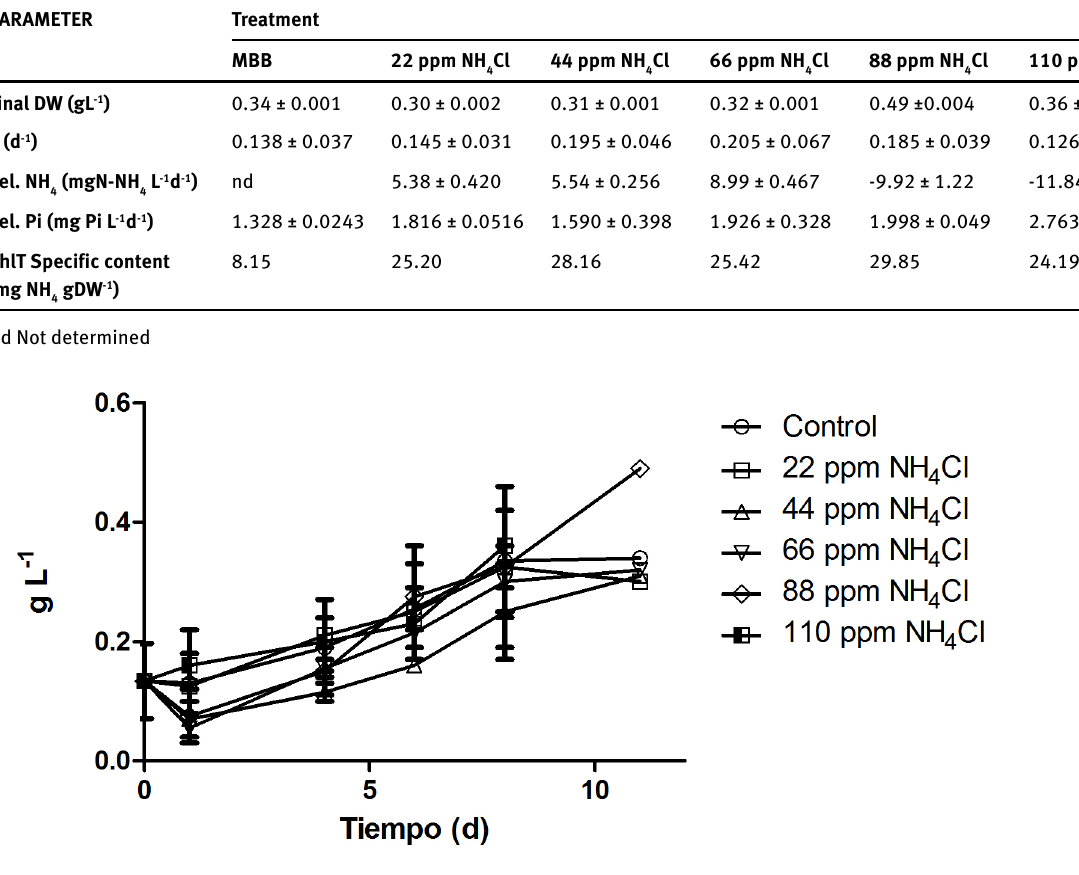
Cl concentrations 4